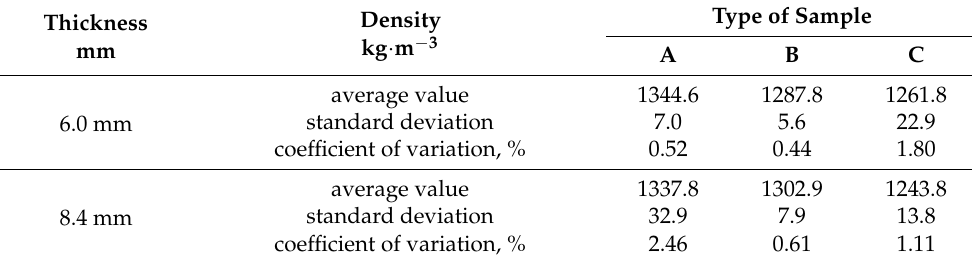
Table 6. Influence of MuCell ® technology on the density of all the PA66 GF30